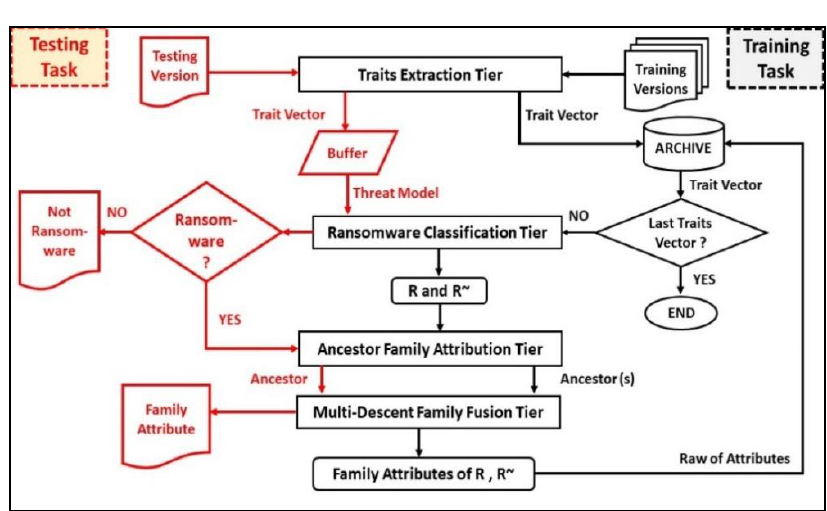
Figure 3. Structure of multi-tier ransomware streaming analytics model.